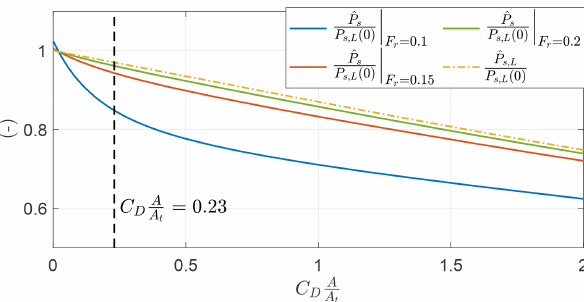
Figure 19. Norm of the optimal AWES velocity v as a function of the angular position.